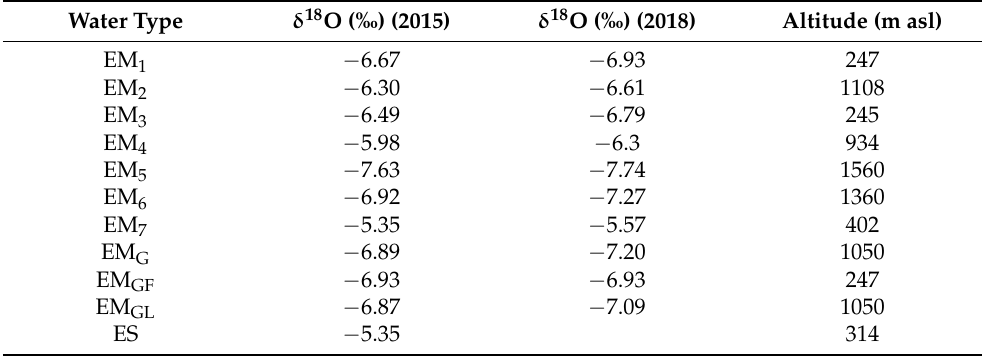
Table 5. Altitude and δ 18 O results of the